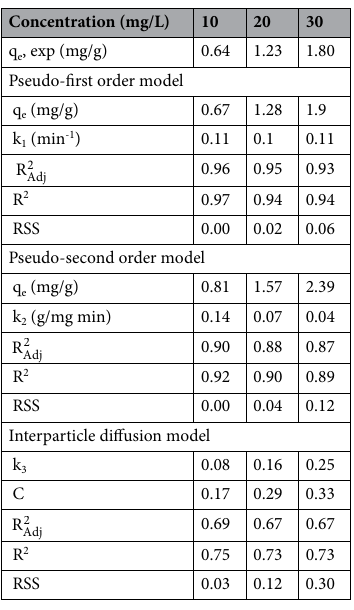
Table 2. Kinetic parameters for Pb(II) adsorption by PG.